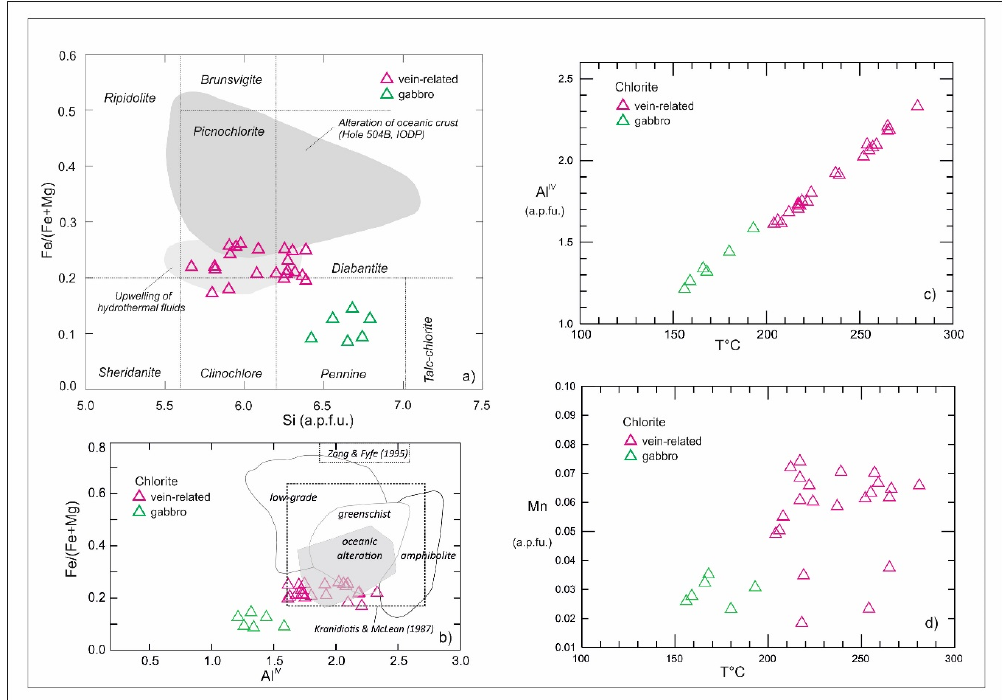
Figure 14. Chlorite composition and geothermometric estimate. ( a ) Chlorite compositional data, distinguished between gabbro hosted (far from ore) and vein-related, plotted in the classification scheme by [59]. Fields for chlorites: [60] for altered oceanic crust (Hole 504B, IODP), [61] from alteration related to upwelling of hydrothermal fluids (Mid-Atlantic Ridge, Galapagos, East Pacific Rise 13° N, Izu-Bonin). ( b ) Plot of Al IV vs Fe/(Fe+Mg) data of Piazza chlorites for comparison with oceanic alteration-related and metamorphic data after [61] and for evaluating the applicability of chlorite geothermometers [62,63]. ( c ) Plot of temperature vs Al IV for the Piazza chlorites according to the chlorite geothermometer proposed by [62]. ( d ) Plot of temperature vs Mn content for the Piazza chlorites.